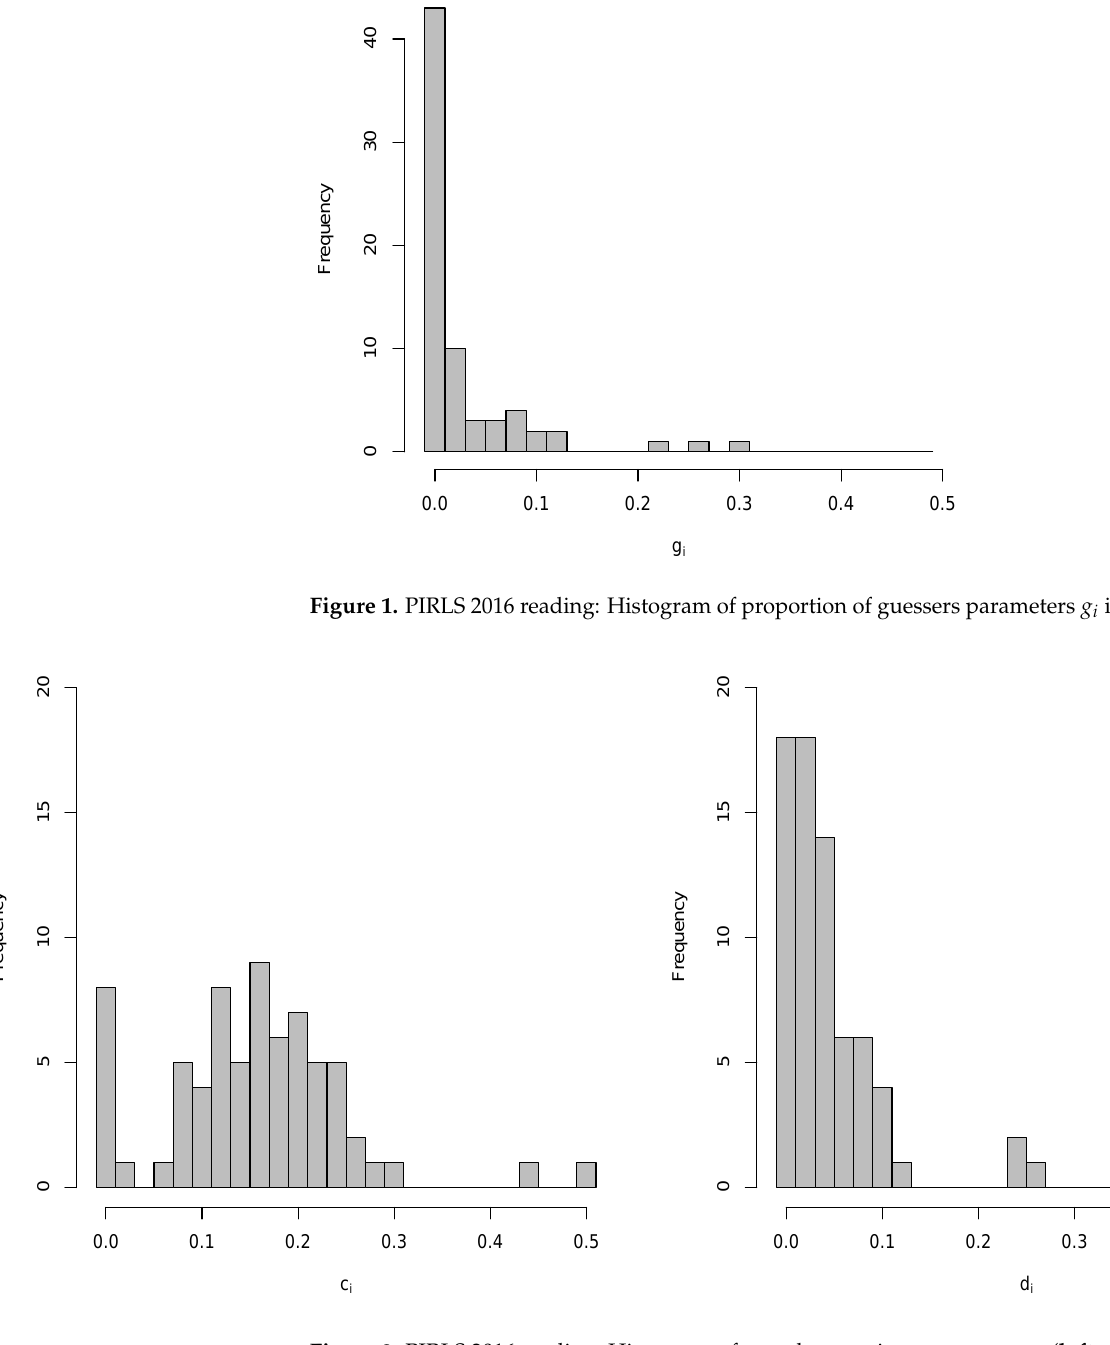
Figure 2. PIRLS 2016 reading: Histogram of pseudo-guessing parameters c i ( left panel ) and slipping parameters d i ( right panel ) in the 4PL